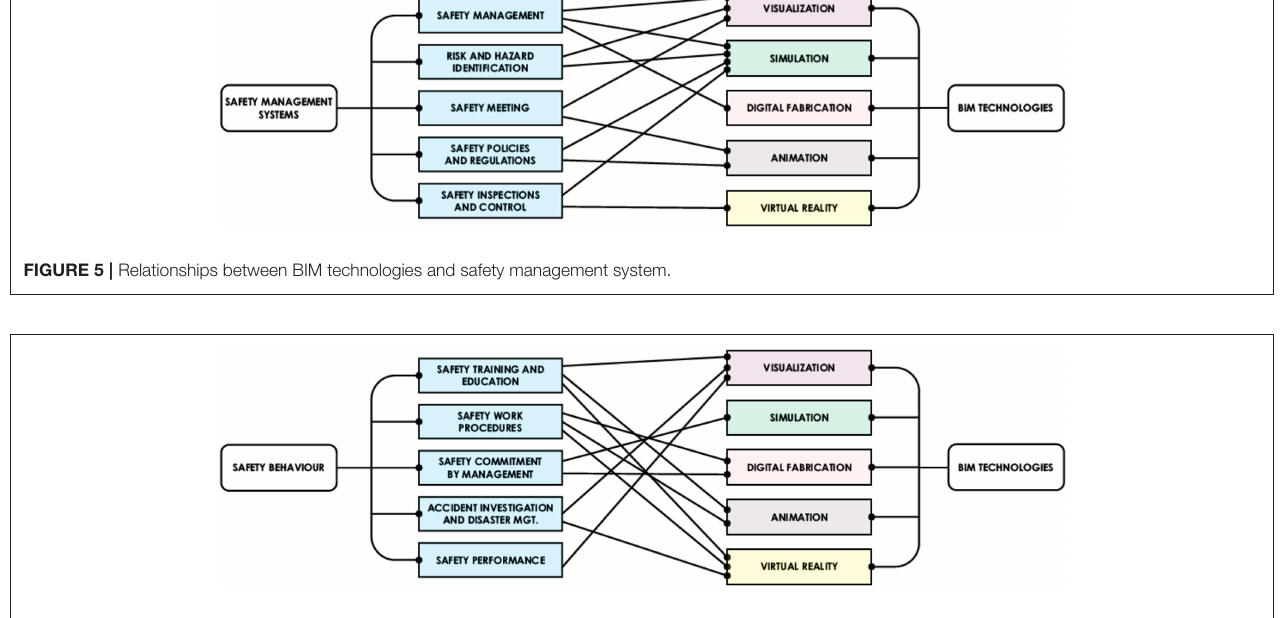
FIGURE 6 | Relationships between BIM technologies and safety behavior.